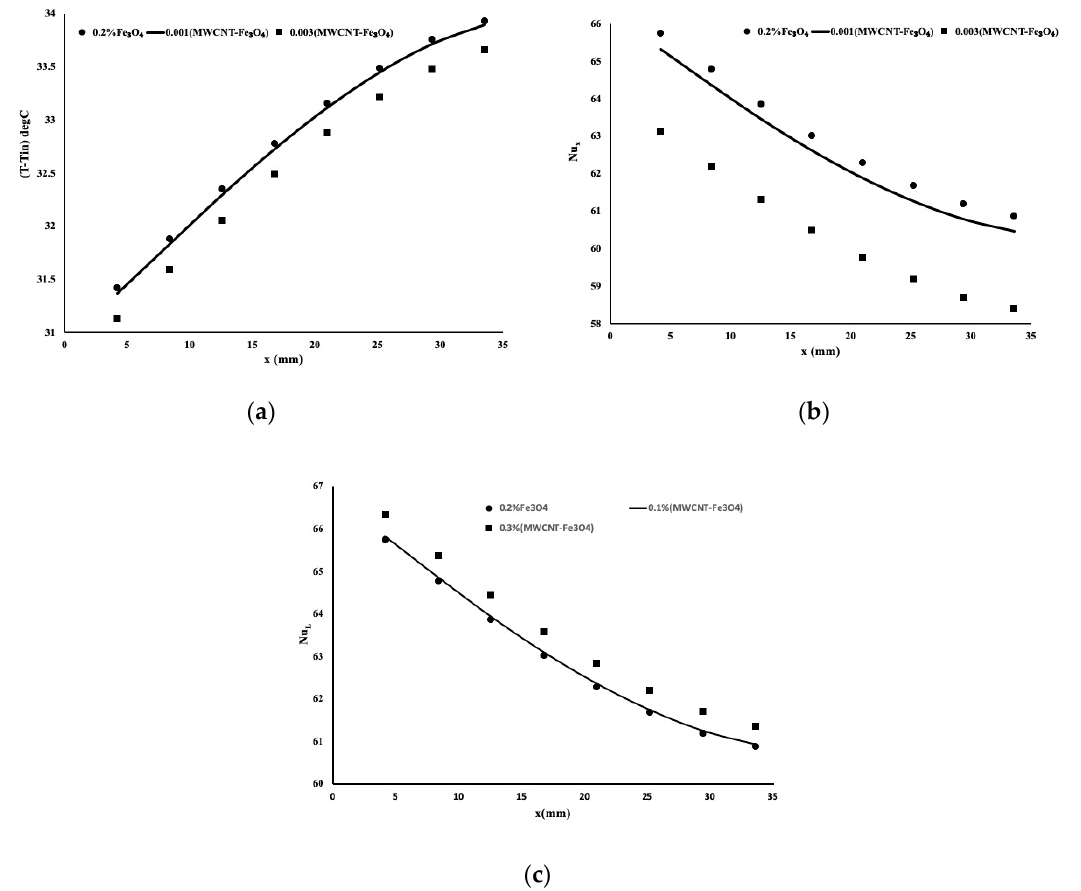
Figure 5. Heat enhancement using the MWCNT– Fe 3 O 4 in water mixture. ( a ) Temperature variation along the flow, ( b ) Nusselt number of each individual mixture, ( c ) Nusselt number using standard